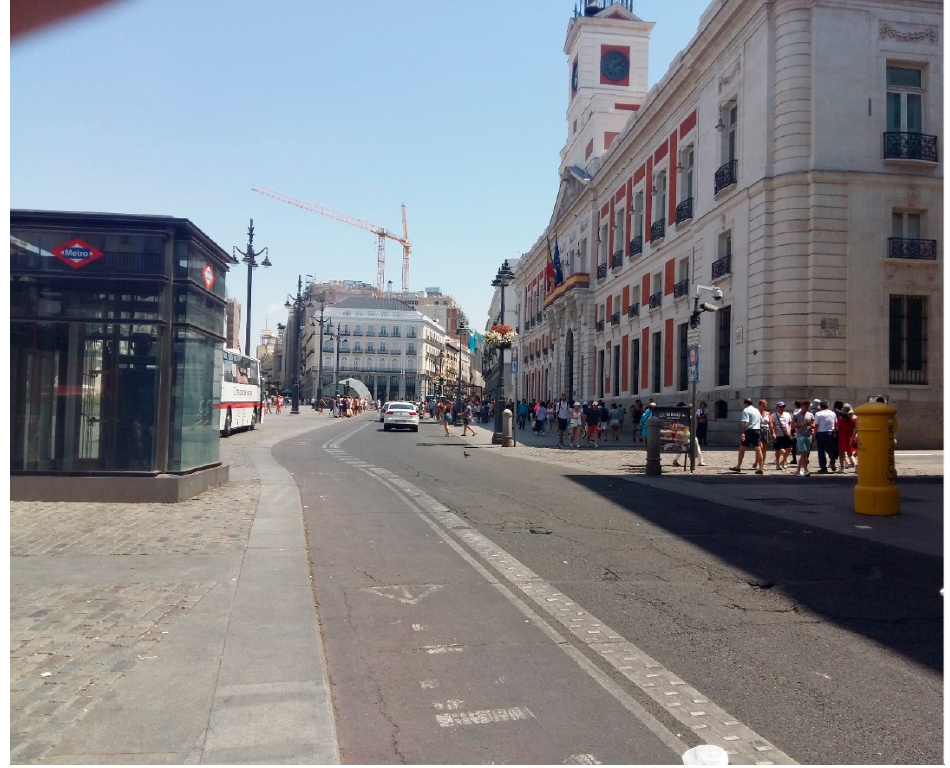
Figure A6. People walking along shady areas in a hot summer day.